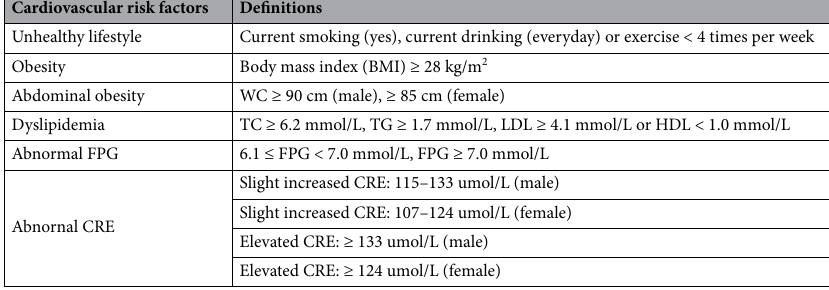
Table 4. Risk factors influencing cardiovascular prognosis in hypertensive patients.